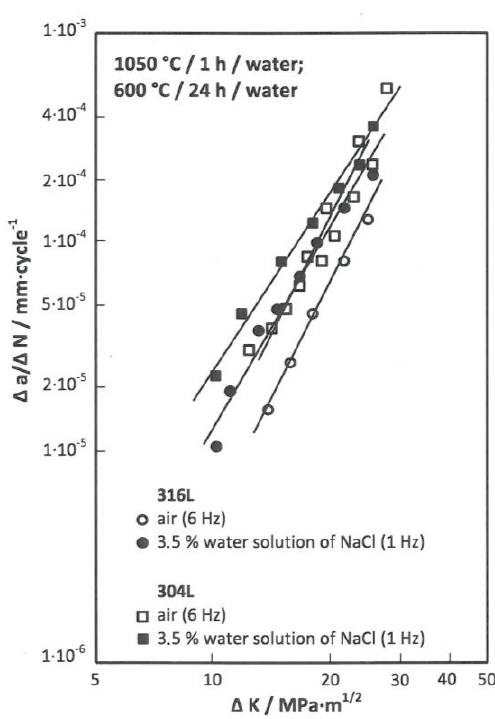
Figure 7. Kinetics of fatigue crack growth for 304L and 316L steels after sensitization